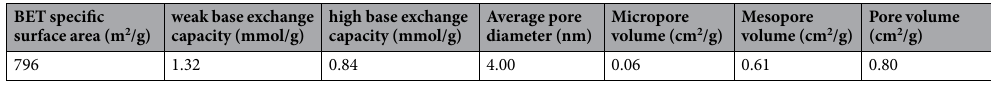
Table 1. Textural and physicochemical properties of M88.